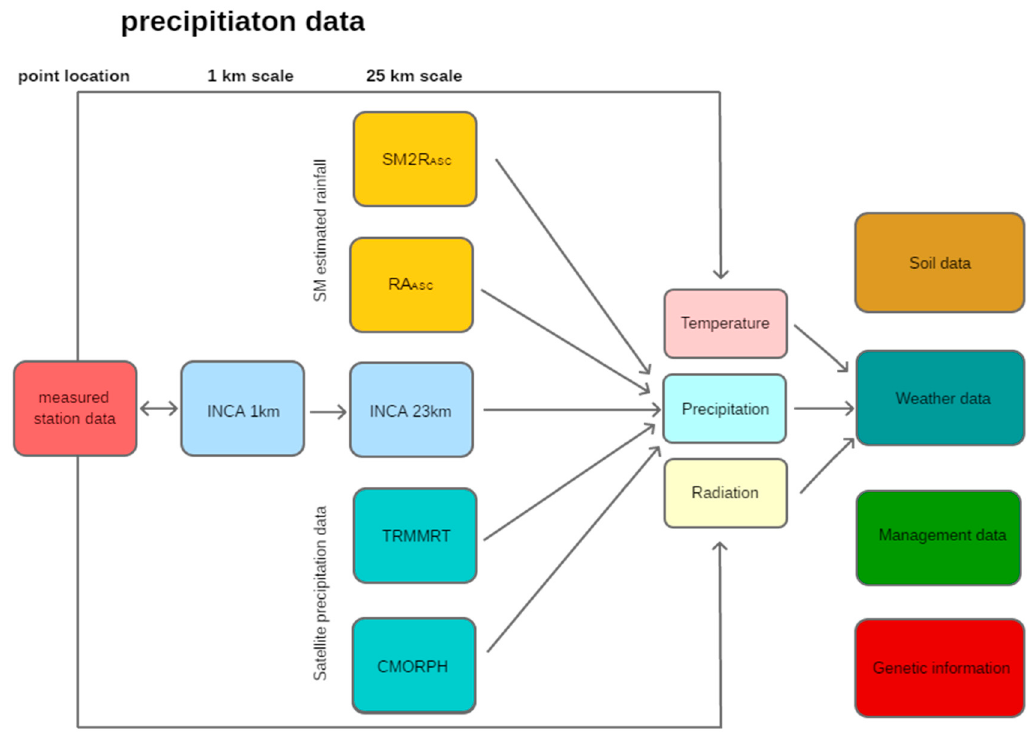
Figure 3. Simple flowchart of the methods used for the evaluation of model performances. SM: soil moisture; INCA: Integrated Now-casting through Comprehensive Analysis; TRMMRT: Multi-satellite Precipitation Analysis; CMORPH: Climate Prediction Center MORPHing.